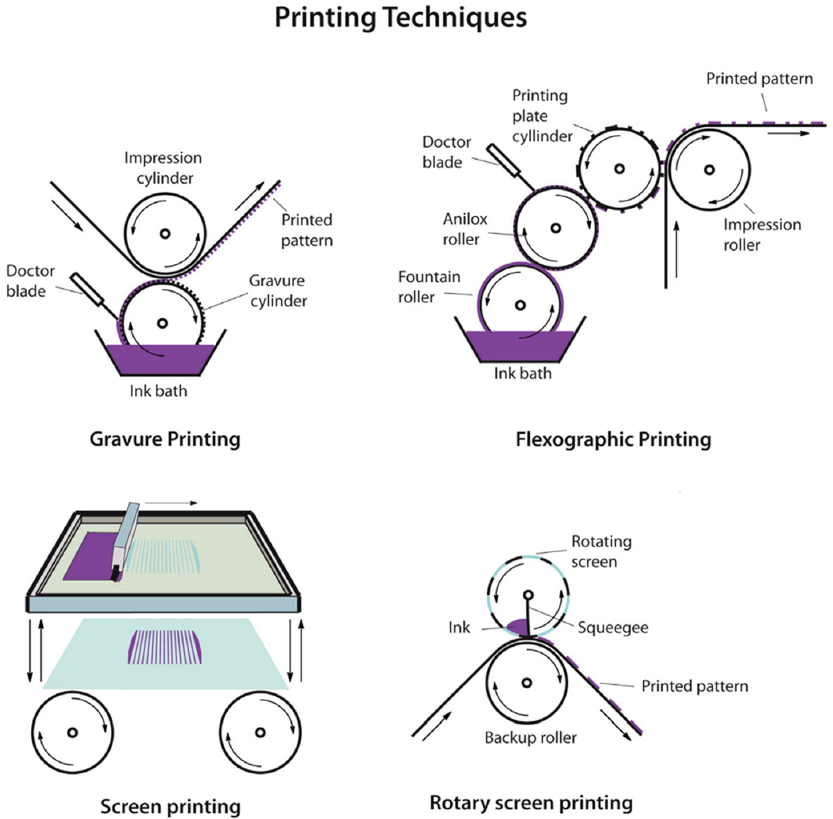
Figure 8. Illustrations of four printing techniques: gravure printing, flexographic printing, screen printing, and rotary screen printing. Reprinted with permission from ref. [27]. Copyright 2012 Elsevier.